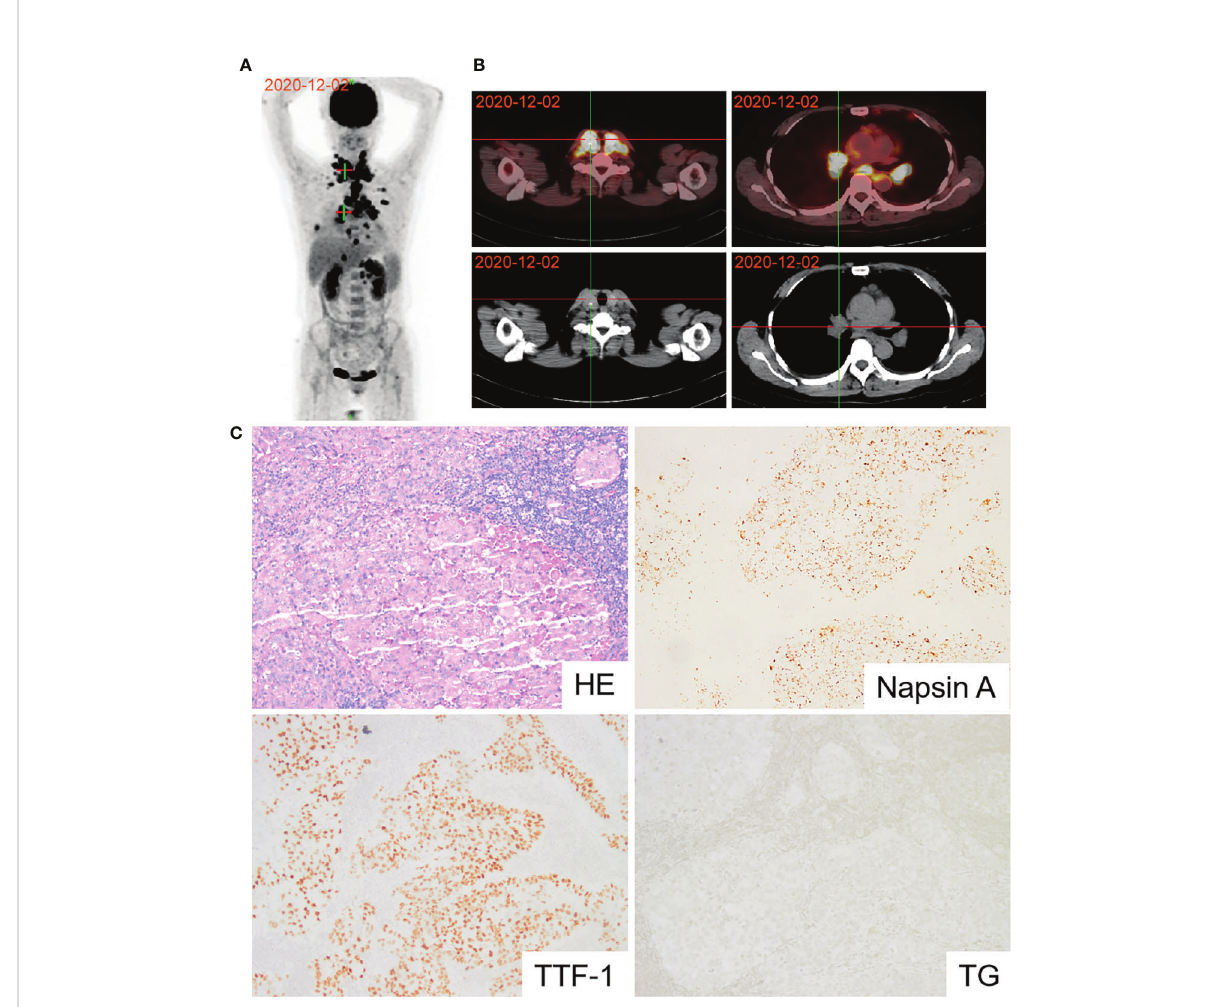
FIGURE 1 Diagnosis of lung adenocarcinoma using PET and pathology. (A) PET-CT scan revealing active metabolic activity in the right lower lobe of the lung, multiple lymph nodes, adrenal gland, pleura and thyroid. (B) PET-CT image of thyroid and lung lesions. (C) Pathological image of lymph node biopsy con fi rming lung